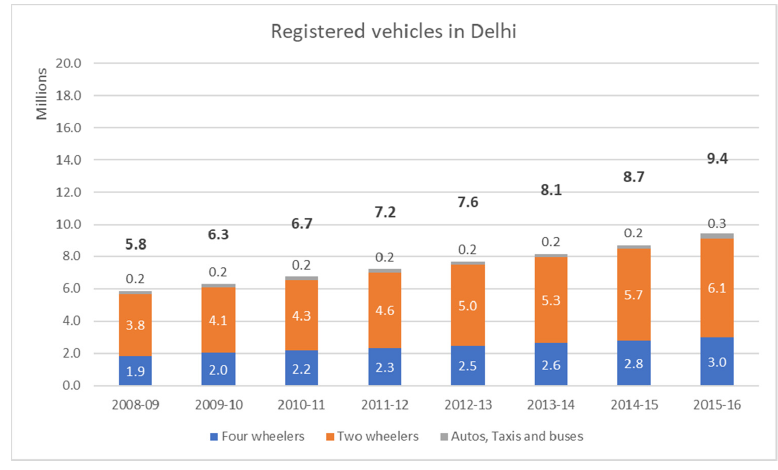
Figure 2. Registered vehicles in New Delhi.